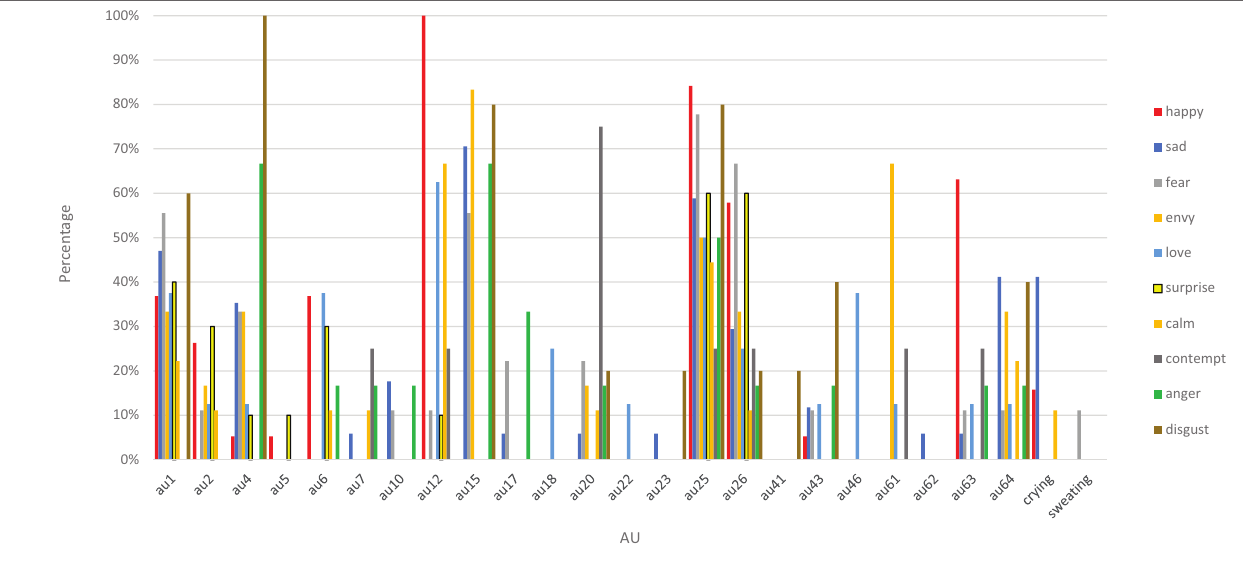
TABLE 6 | Percentage of AUs (as a total of number of AUs) by